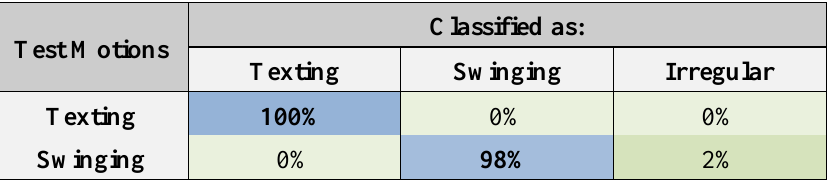
Table 3. Confusion matrix for the ―controlled‖ data collection